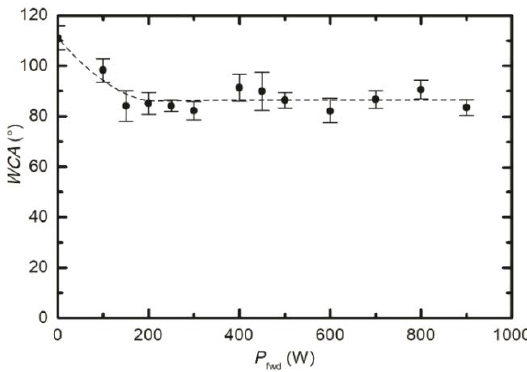
Figure 3. Variation of surface wettability with treatment time. The samples were inside the radiofrequency (RF) coil. Discharge power and hydrogen pressure were constant at 400 W and 25 Pa, respectively.